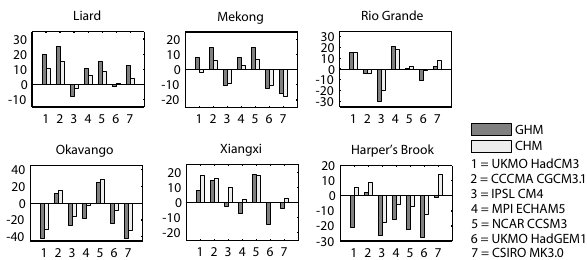
Fig. 8. Change in mean annual runoff relative to baseline (vertical axis; %) for the 7GCMs under 2 ◦ C prescribed warming (horizontal axis), as simulated by the GHM and CHM respectively, for each